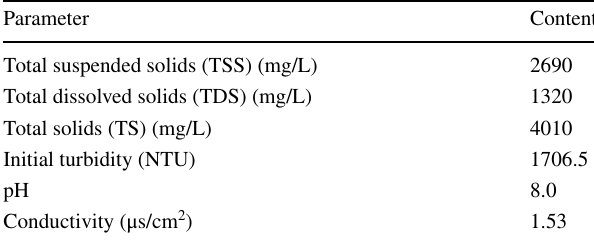
Table 1 Characteristics of paint wastewater (PWW) characterization